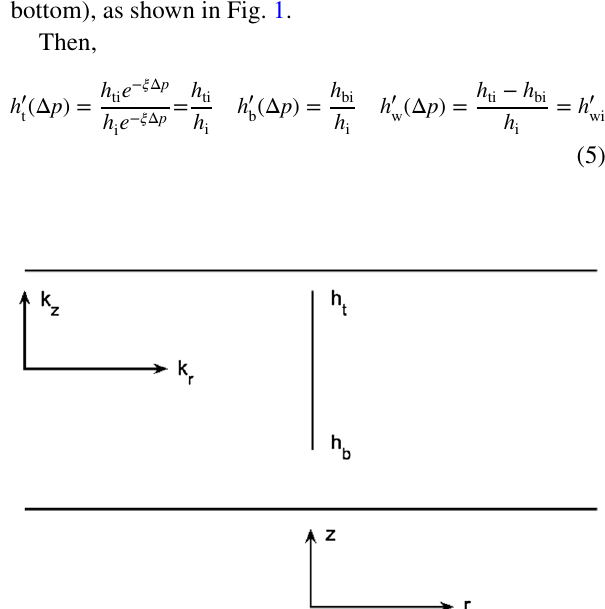
Fig. 1 Restricted entry well in an infinite-acting reservoir Fig. 2 a Length of well at initial pressure, b length of well at a reduced